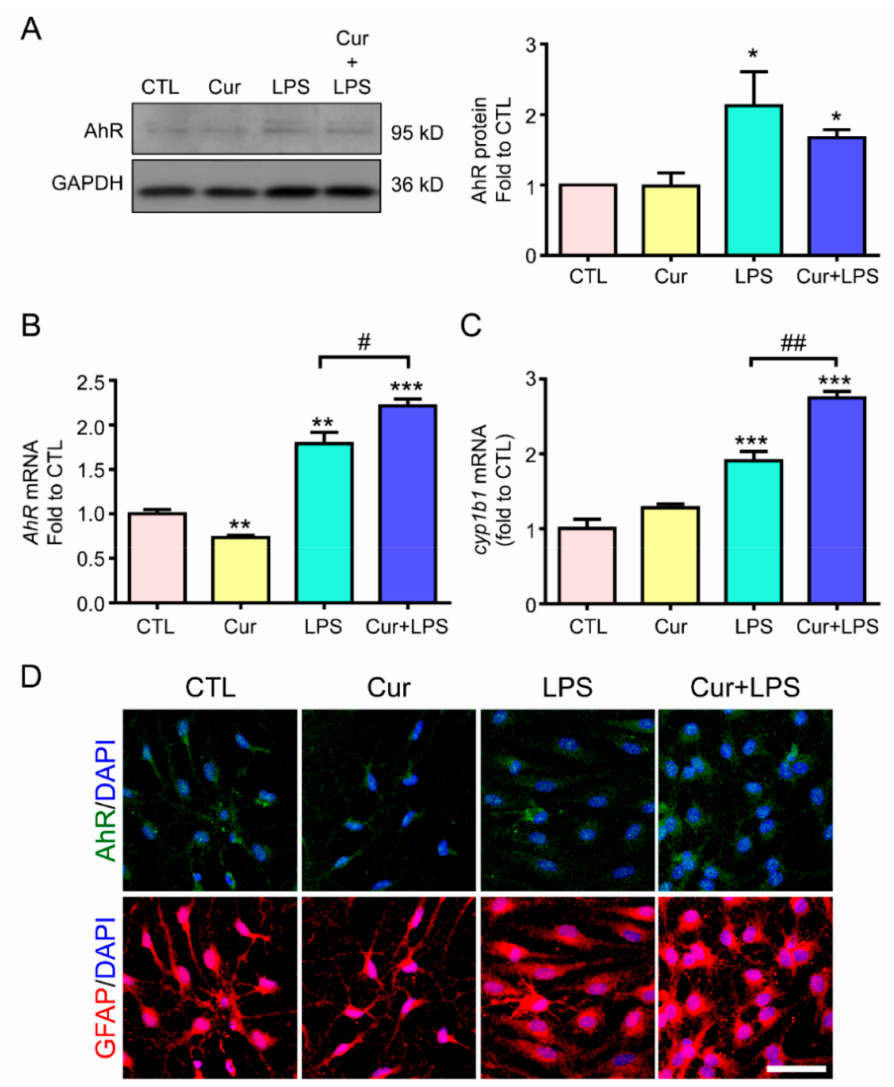
Figure 3. Curcumin enhanced LPS-induced AhR activation and nuclear translocation in astrocytes. Primary astrocytes were treated with 1 µ g/mL LPS, 1 µ M curcumin (Cur), or their combined treatment for 12 h in RNA and 24 h in protein. ( A ) AhR protein expression was determined by western blotting. GAPDH was used as the loading control. A representative blot and the quantification results are shown. n = 3. ( B , C ) AhR ( B ) and CYP1B1 ( C ) mRNA expression was determined by RT-PCR. Results are presented as fold expression differences over the control condition. ( D ) Immunofluorescence was performed to evaluate the expression of AhR (green, upper panel) and GFAP (an astrocyte marker; red, lower panel); DAPI (blue) was used to counterstain the nuclei. Representative images are shown. Note that curcumin enhanced LPS-induced AhR mRNA, not protein level, and elevated LPS-increased CYP1B1 mRNA expression and AhR nuclear translocation in astrocytes. Scale Bar = 20 µ m. Statistical differences were analyzed using the unpaired t -test, and represented as: * p < 0.05, ** p < 0.005, *** p < 0.001 compared with the control group and # p < 0.05, ## p < 0.01 compared with the LPS group. DAPI, 4 (cid:48)